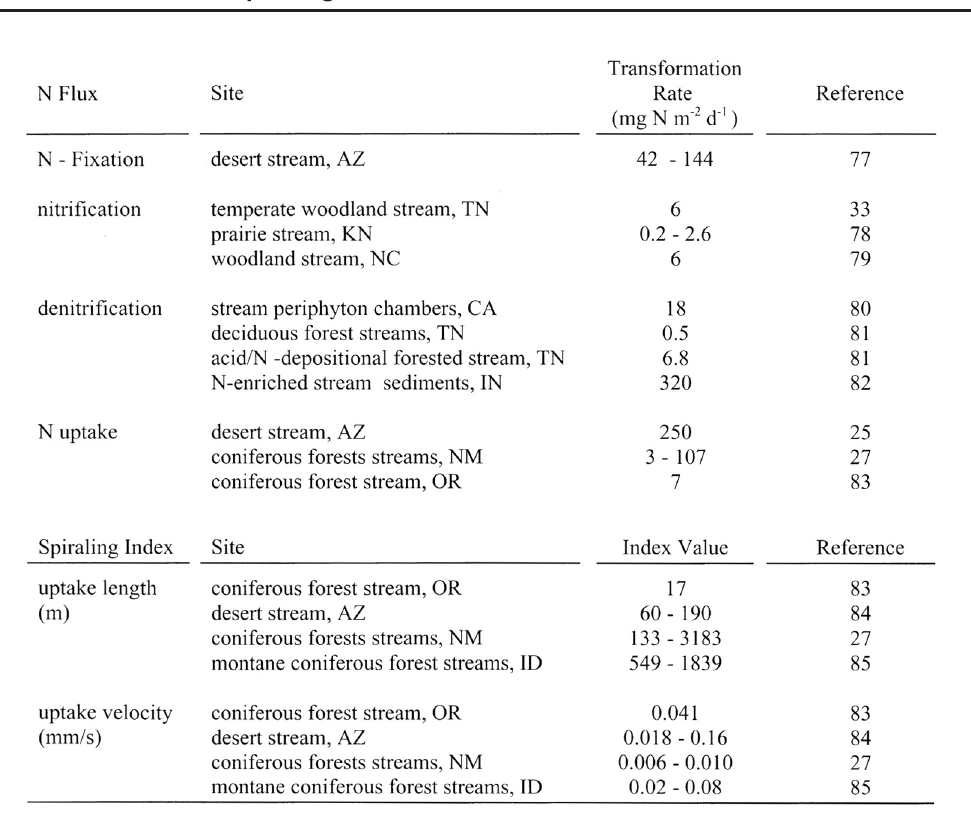
N Transformation Rates and Spiraling Indices for Selected Headwater Streams, U.S., North